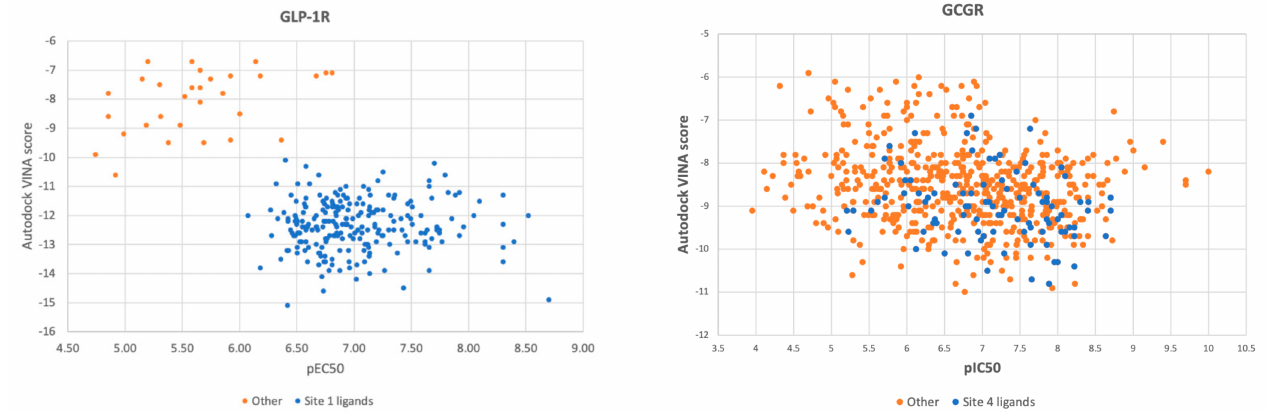
Figure 4. Comparison of Autodock VINA scores obtained from flexible ligand-flexible receptor molecular docking with pEC 50 (GLP-1R, left) and pIC 50 (GCGR, right)